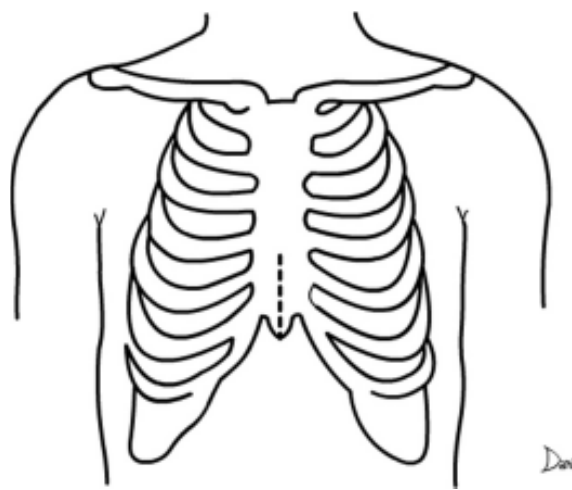
Fig. 1 - Incisão esternal limitada utilizada nesta